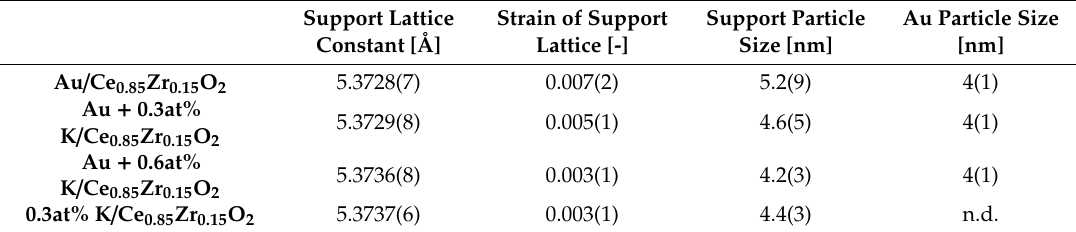
Figure 1. X-ray Di ff raction patterns of Au / Ce 0.85 Zr 0.15 O 2 and Au + K (0.3 and 0.6 at%) / Ce 0.85 Zr 0.15 O 2 catalysts and the support doped with 0.3 at% potassium. Figure 1. X-ray Diffraction patterns of Au/Ce 0.85 Zr 0.15 O 2 and Au + K (0.3 and 0.6 at%)/Ce 0.85 Zr 0.15 O 2 catalysts and the support doped with 0.3 at% potassium. Table 1. Results of X-ray Di ff raction studies: Support lattice parameter, strain of support lattice, average particle size of support and gold in catalysts, and the potassium-doped support; the regression error of the last figure is shown in